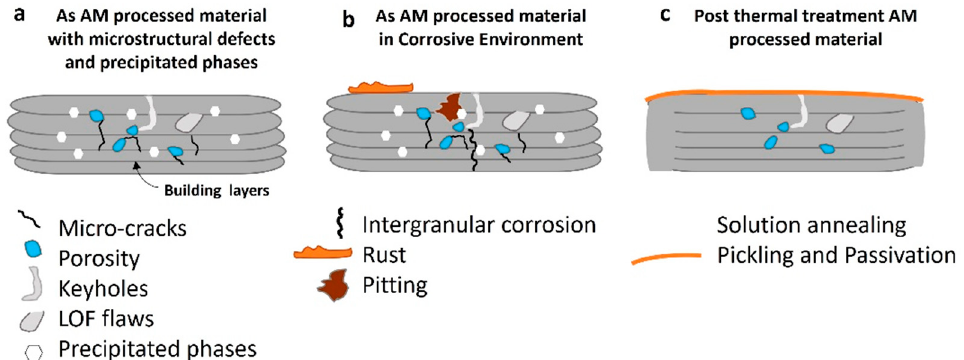
Figure 3. ( a ) Schematic representation of an AM-processed material and the presence of several microstructural defects (micro-cracks, porosity, keyholes, and LOF flows, as represented); ( b ) the same AM processed material in a corrosive environment where intergranular corrosion, pitting corrosion, and rust on the surface can appear; ( c ) the same AM-processed material after being thermally treated (solution annealing) to remove residual stresses and precipitated secondary phases after pickling and passivation as a preventive measure for corrosive environments.